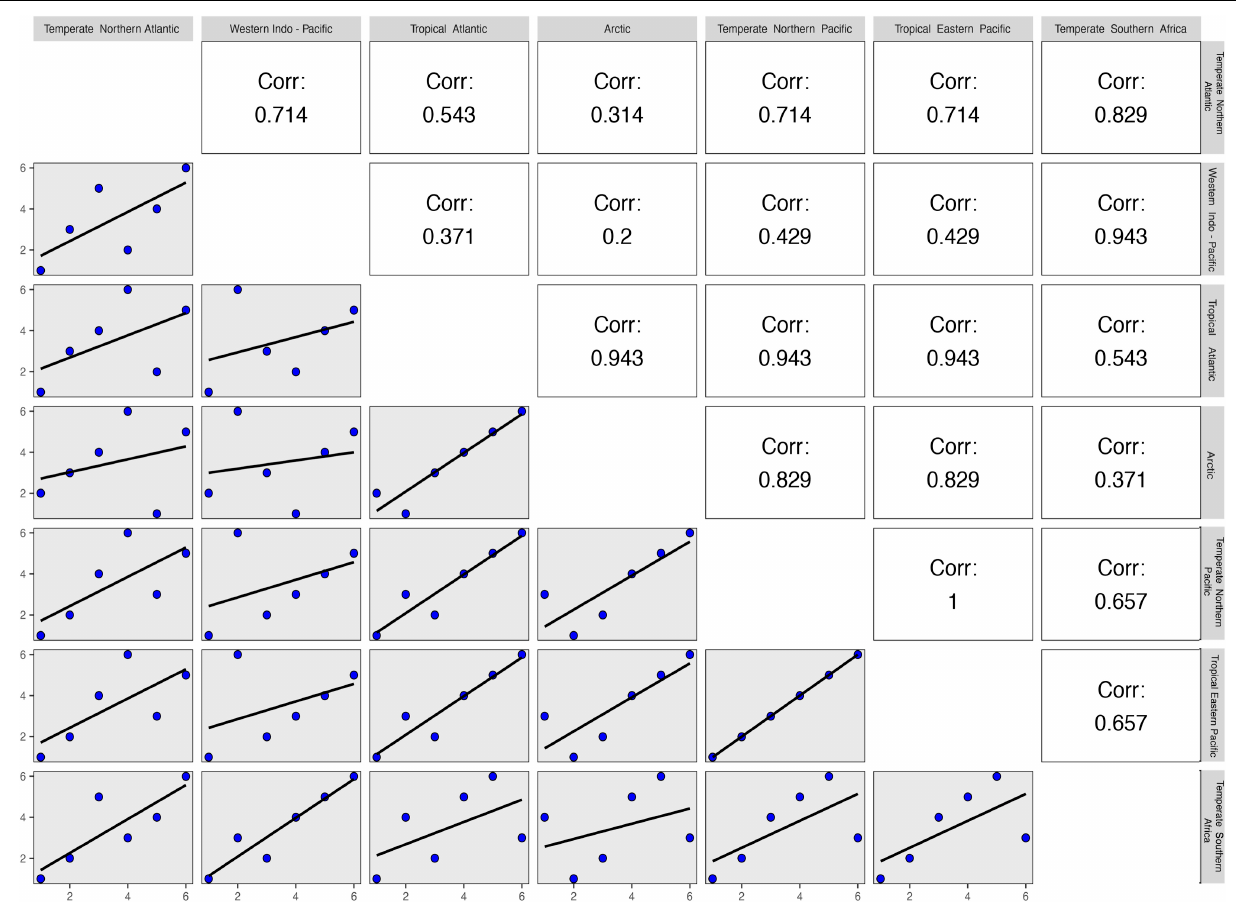
FIGURE 7 | Correlations of family ranks possessing threatened seagrass species across marine ecoregions of the world (MEOWs). The pairwise correlational analysis assigned values based on the level of overlap of seagrass families across MEOWs that possessed seagrass species classified as threatened by the International Union for Conservation of Nature. Low correlation values were generally reported between temperate and tropical MEOWs, indicating that the threatened seagrass species in these regions are unique to those areas. Source data are provided as a Source Data